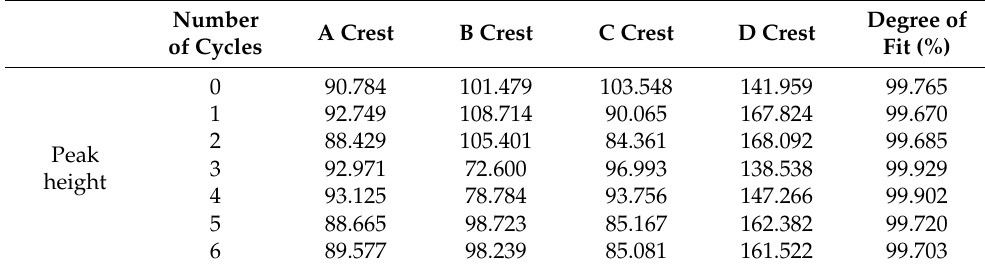
Table 3. Fitting degree and peak height of each wave peak.